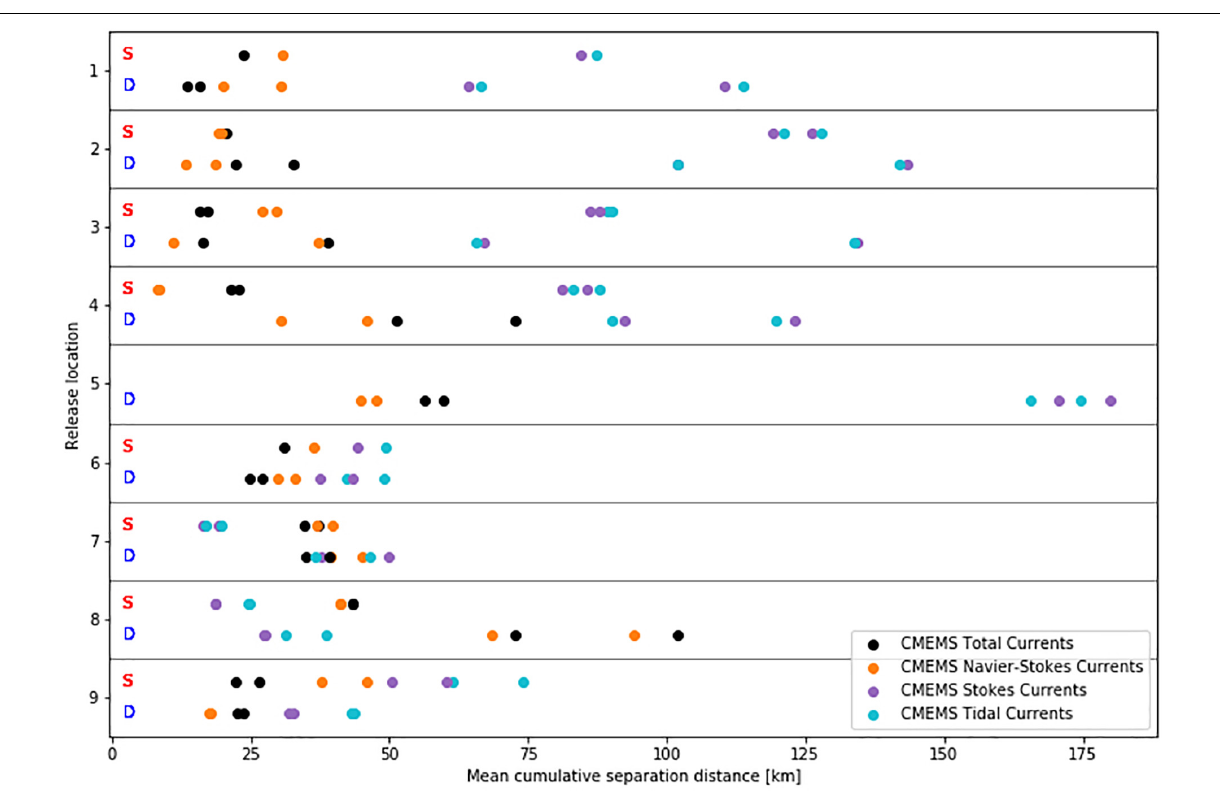
FIGURE 8 | Mean cumulative separation distance for the first 5 days between the virtual particles advected in the CMEMS-SMOC flow fields, and the two types of drifters (undrogued Stokes drifters on the lines with red “S,” drogued SVP drifters on the lines with blue “D”), shown for each of the nine release locations. Distances were only computed for drifters that have at least 5 days of